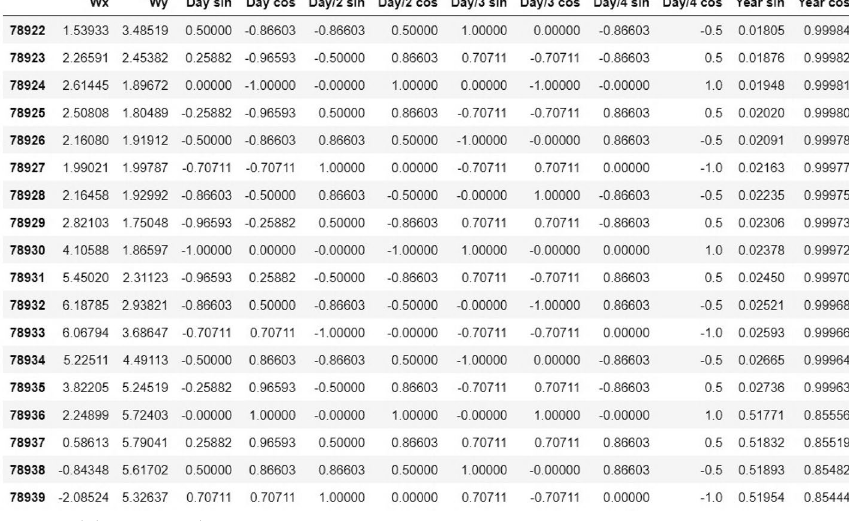
Fig. 24 Validation input